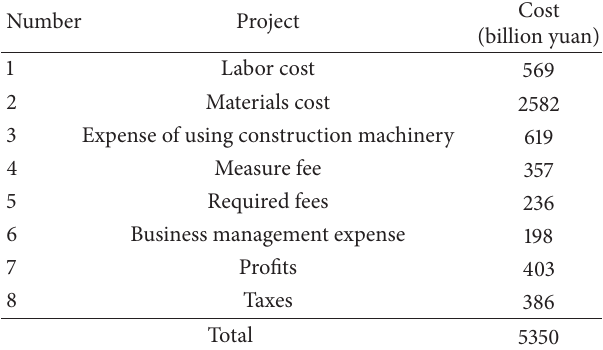
Table 4: Forecast costs of mechanical and electrical installation project in SN Insecticide